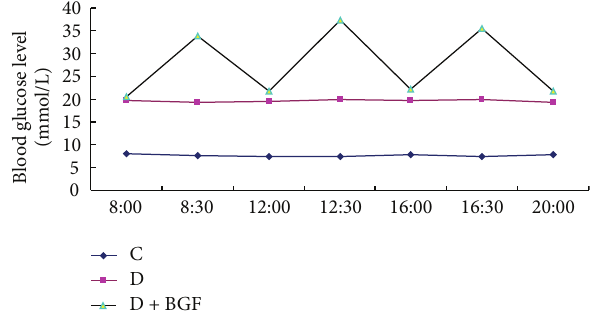
Figure 1: Blood glucose level in the mice at one day after eight-week BGF treatment.